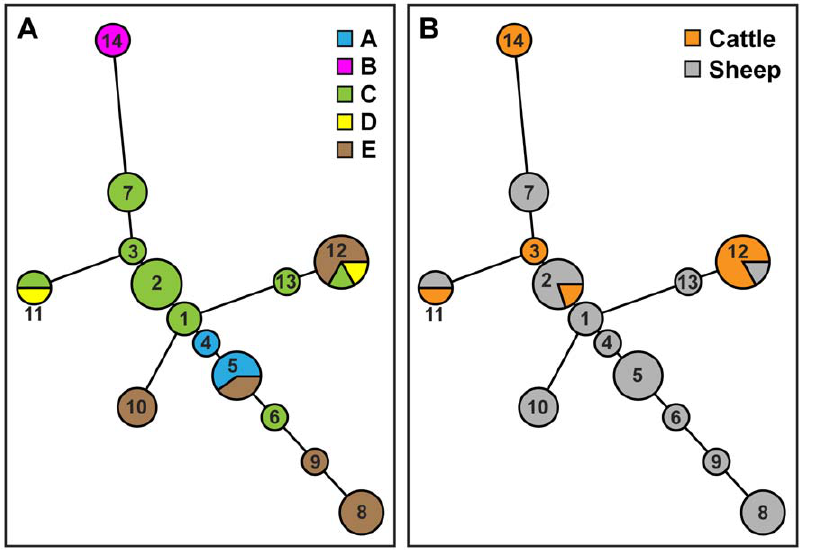
Figure 5. Phylogenetic relationships of MLVA types for the 37 non-O157 STEC isolates. A minimum-spanning tree was generated with Bionumerics software v61 and the Manhattan distance algorithm. Each circle in the tree represents a different MLVA type, and the number in the circle indicates the MLVA type number. The circle size corresponds to the number of isolates with an identical MLVA type. Colors represent the sampling sites (A) or the sampling source (B) for each MLVA type.